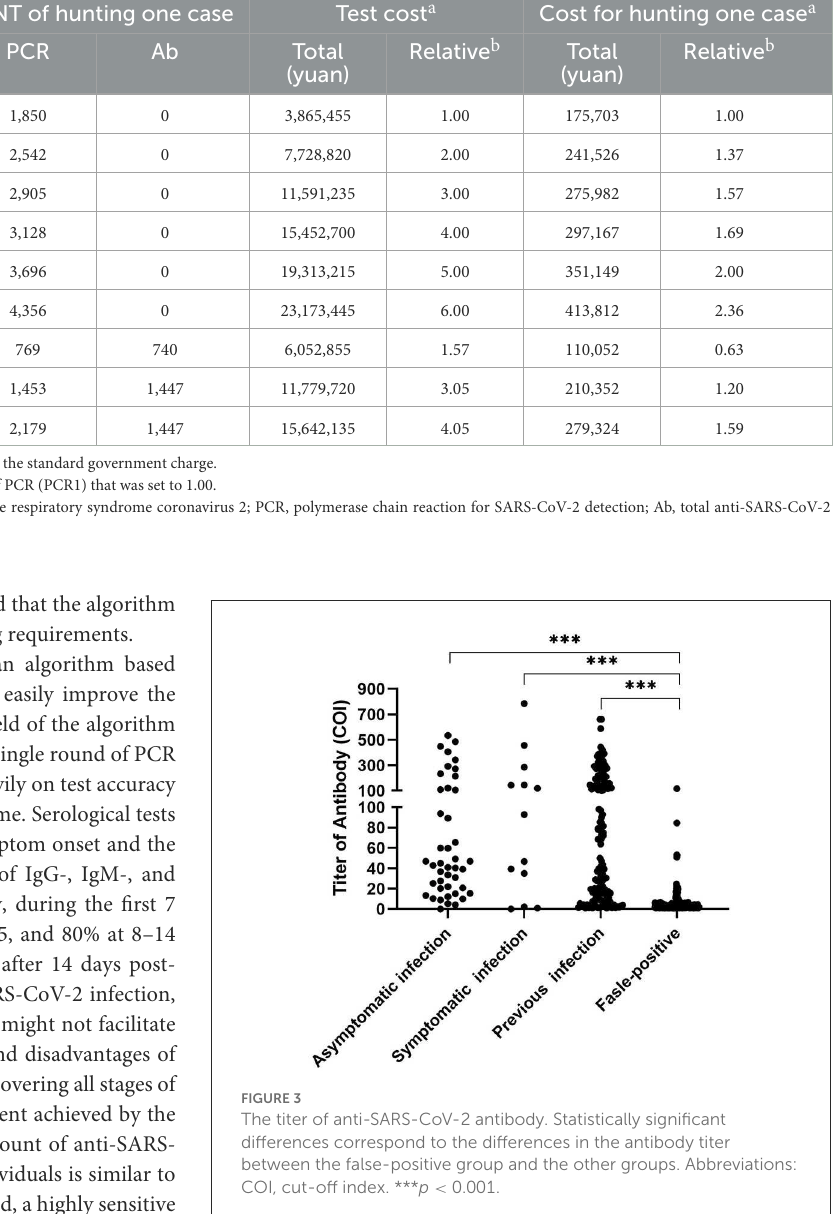
TABLE 4 The costs of SARS-CoV-2 testing algorithms. Strategy